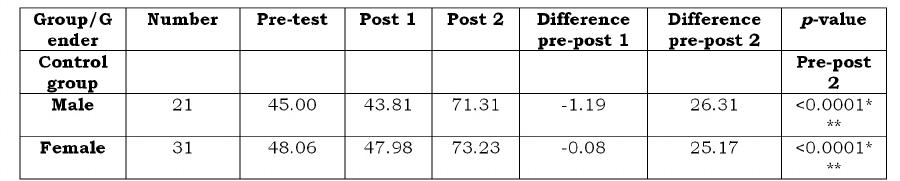
Table 6: Percentage knowledge scores of males and females: control